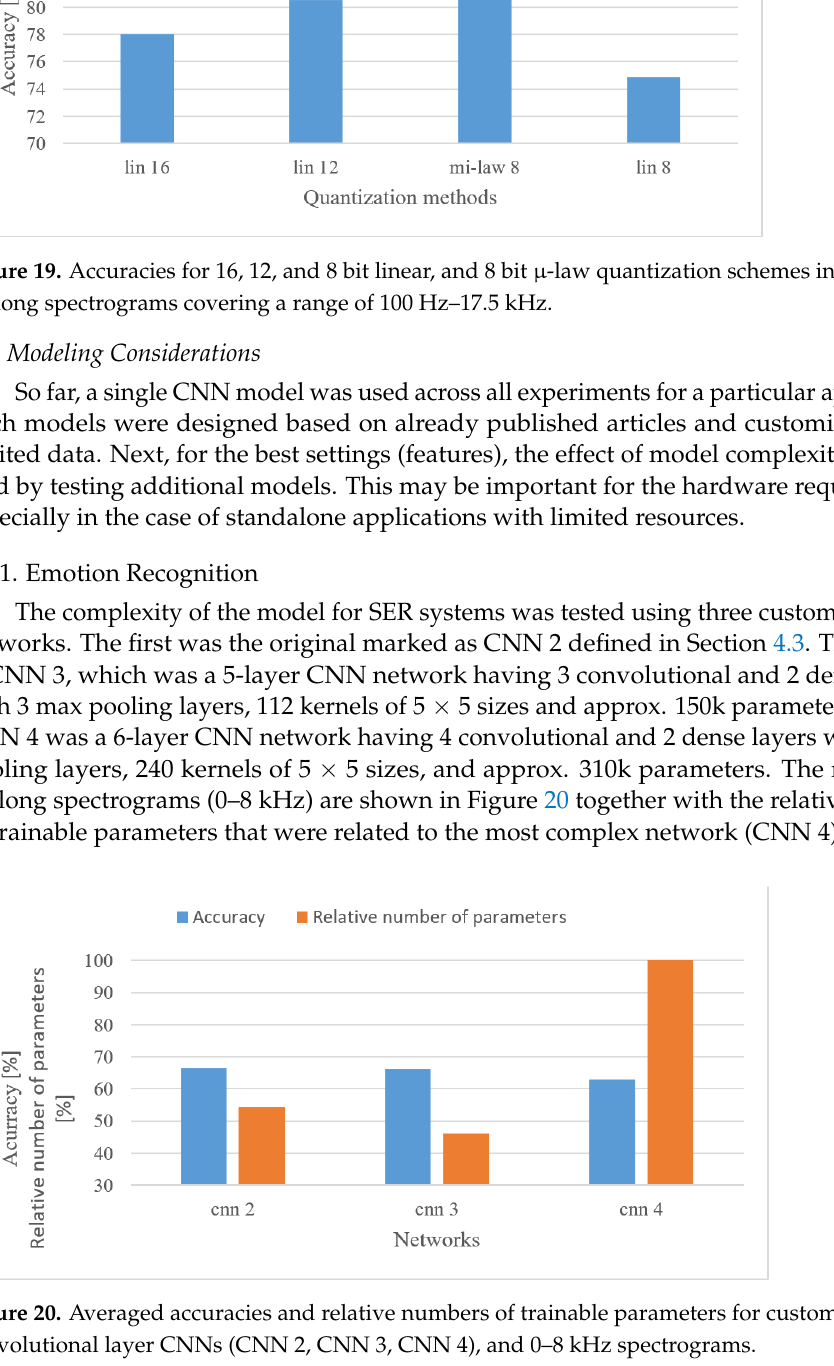
Figure 18. Accuracies for 16, 12, and 8 bit linear, and 8 bit μ -law quantization schemes in the case of spectrograms (spect) and MFBs.